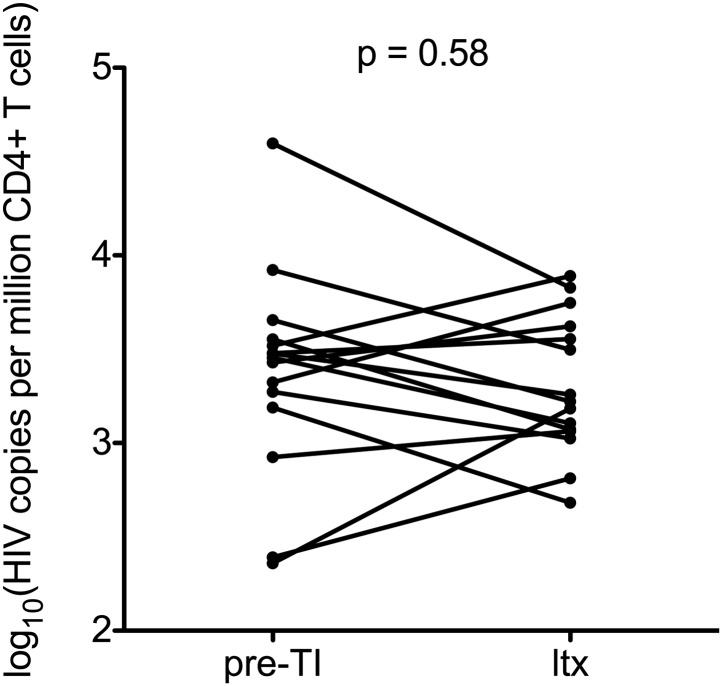
Impact of stopping and re-starting ART on HIV-1 DNA.Total HIV-1 DNA levels were calculated in 15 patients on ART before TI (pre-TI) These patients subsequently started long-term ART (ltx). DNA was sampled at least 6 months post ltx start date. Significance was established using a paired students t test.